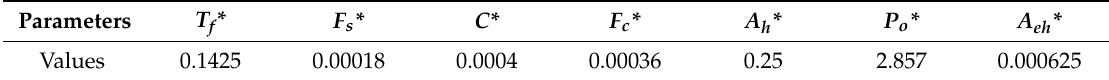
Table 2. Values of the dimensionless parameters.